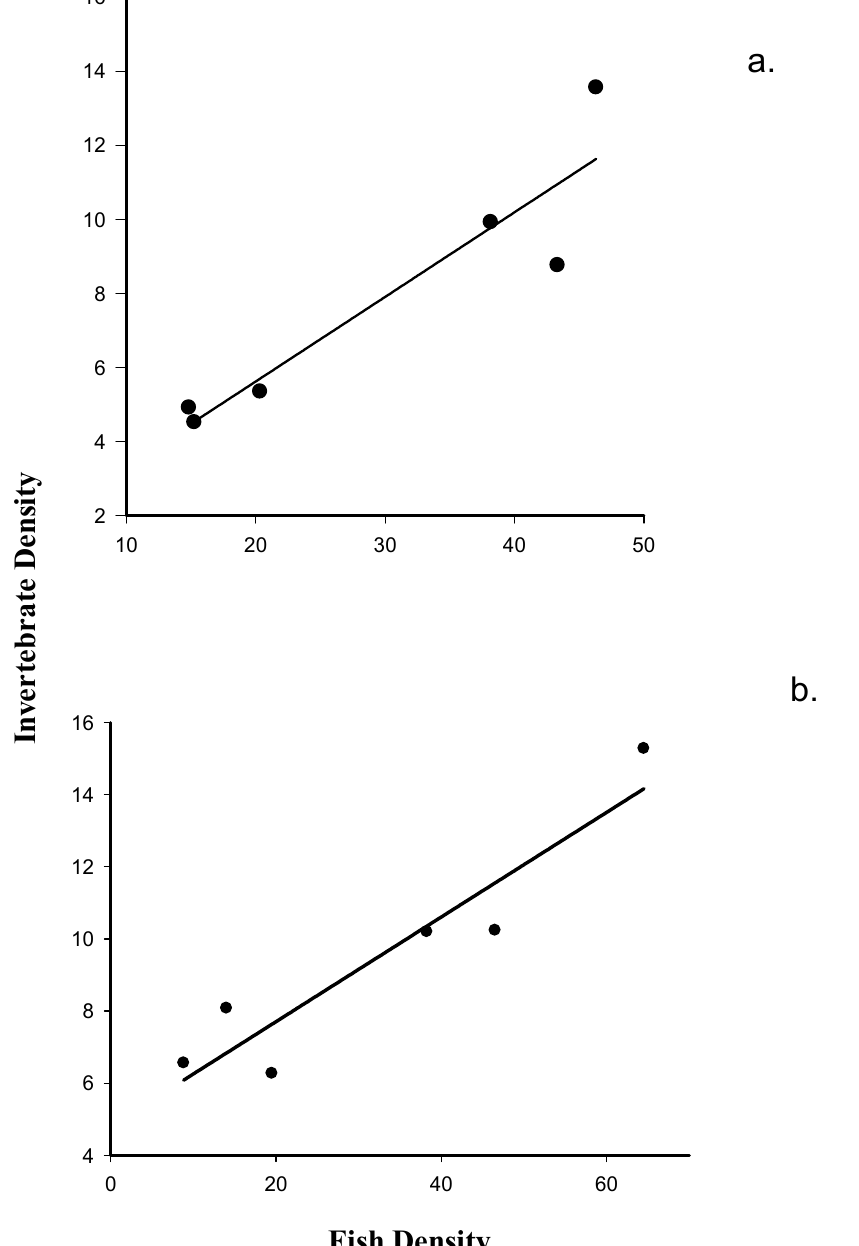
Figure 2. ( a ). Model II regression of benthic macroinvertebrate emergence on nocturnal fish counts at Dry Rocks Reef; and ( b ). Model II regression of benthic macroinvertebrate emergence on nocturnal fish counts at Newfound Harbor